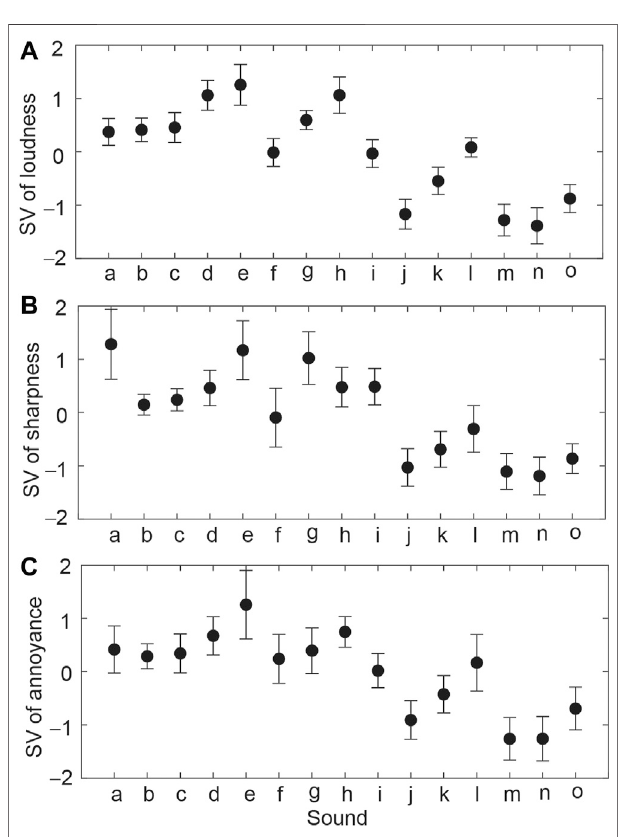
FIGURE 5 | Scale values of (A) loudness, (B) sharpness, and (C) annoyanceforeachparticipant.Thesymbolsindicatethemeanvaluesandthe error bars indicate the standard deviations.